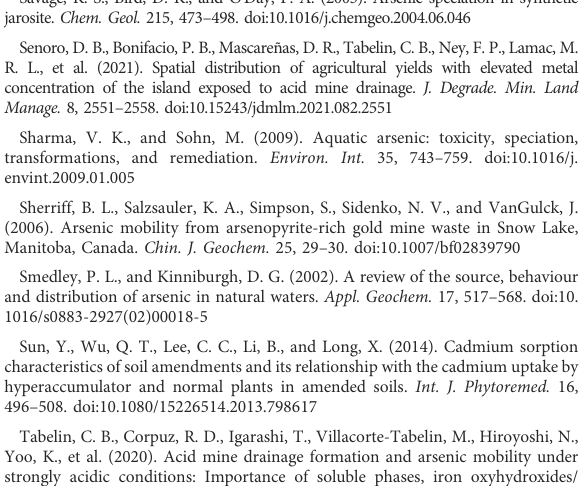
Tabelin, C. B., Hashimoto, A., Igarashi, T., and Yoneda, T. (2014). Leaching of boron,arsenicandseleniumfromsedimentaryrocks:II.pHdependence,speciation and mechanisms of release. Sci. Total Environ. 473-474, 244 – 253. doi:10.1016/j. scitotenv.2013.12.029 Tabelin, C. B., and Igarashi, T. (2009). Mechanisms of arsenic and lead release from hydrothermally altered rock. J. Hazard. Mater. 169, 980 – 990.